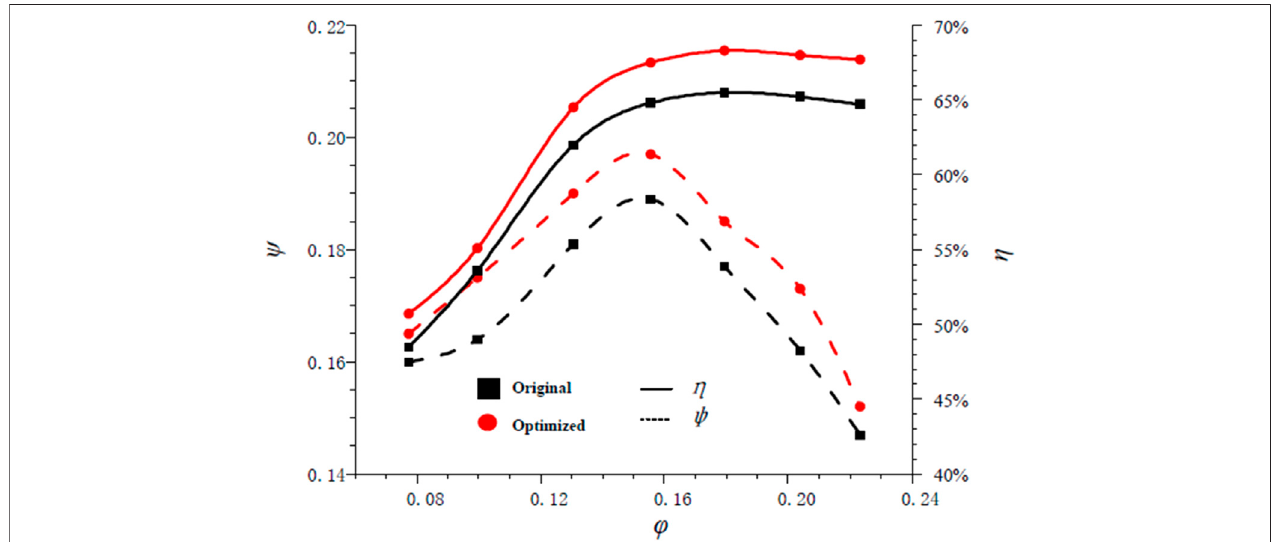
FIGURE 16 | Original and optimized fan performance curves.